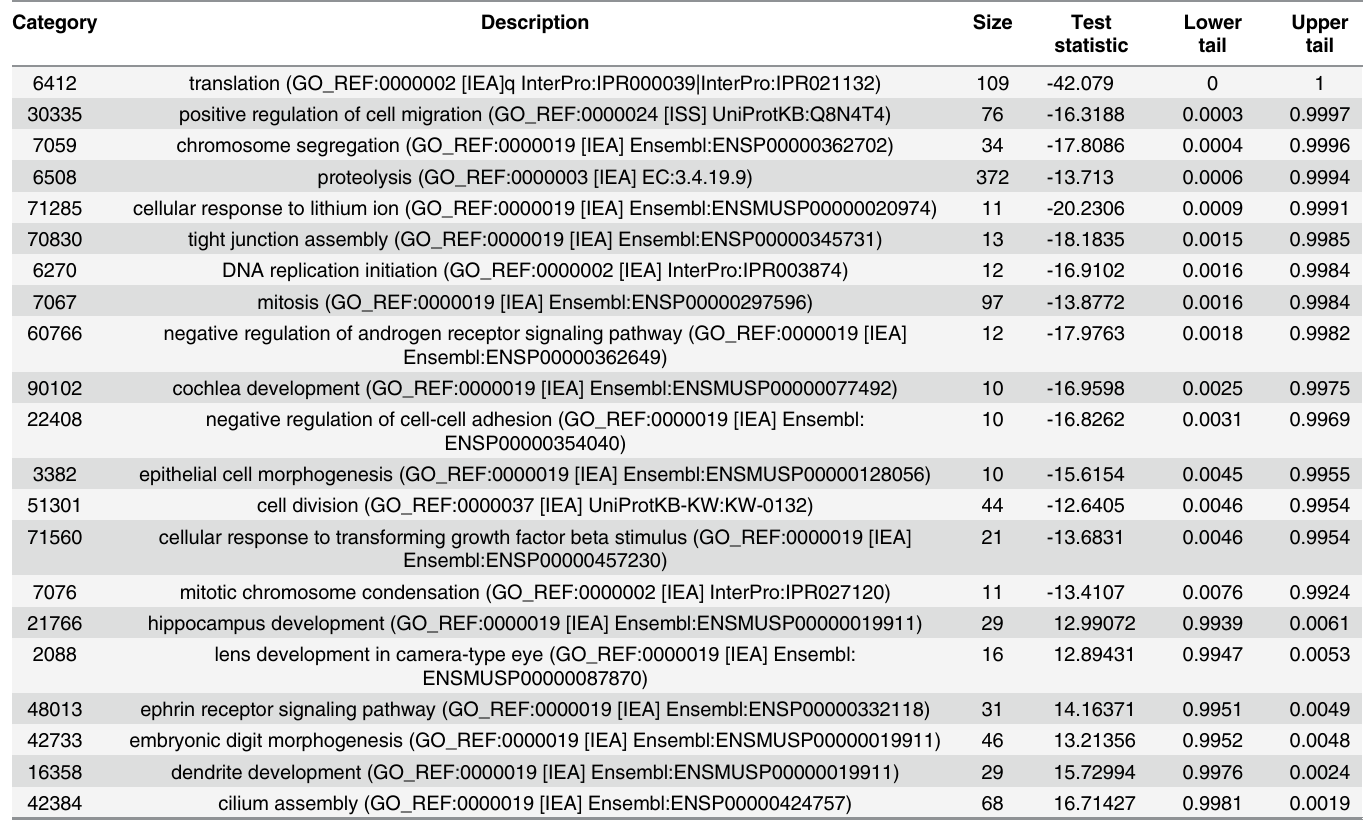
Lower and Upper tail values show the mass in the permutation based p-value distribution below or above the value of the test statistic. P values represented as 0 are less than 10 -16